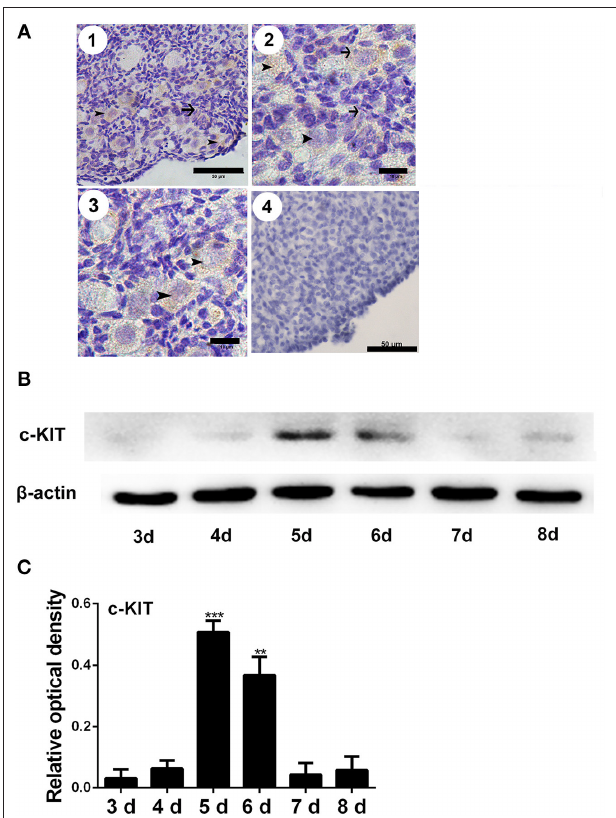
FIGURE 2 | Changes of c-KIT during primordial follicle formation. Brown staining indicates c-KIT, arrows, and arrowheads represent the somatic cells and oocytes, respectively, in 6-day-old chicken ovaries ( A -1, scale bar: 50 µ m). An enlarged picture is also included ( A -2 and 3, scale bar: 10 µ m). A negative control ( A -4, scale bar: 50 µ m). (B) Expression of c-KIT by Western blot in 3 to 8-day-old chicken ovaries, normalized to β -actin. (C) Gray analysis indicates that c-KIT had increased significantly from days 4 to 6. T -tests were used to determine statistically significant differences. The values are the mean ± SEM of six experiments. Asterisks indicate significant differences (** P < 0.01, *** P < 0.001).